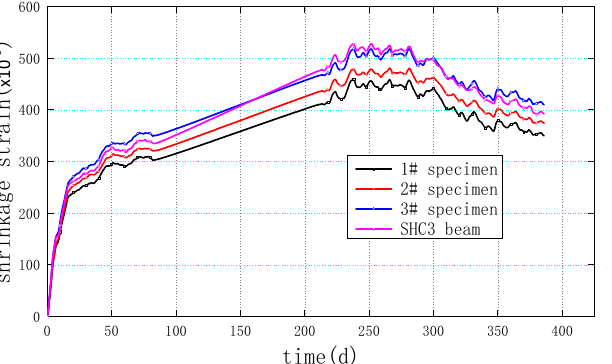
Figure 7. Time-history plots of the shrinkage strain of various specimens (excluding the tempera- ture effect). Table 3. Shrinkage strains at different times.